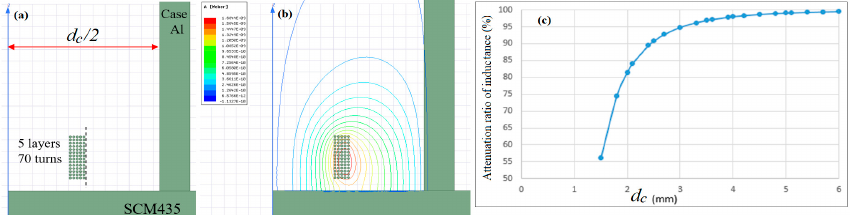
Figure 5. ( a ) Coil winding arrangement with 5 layers, ( b ) magnetic flux, and ( c ) effect of case inner diameter on inductance attenuation.